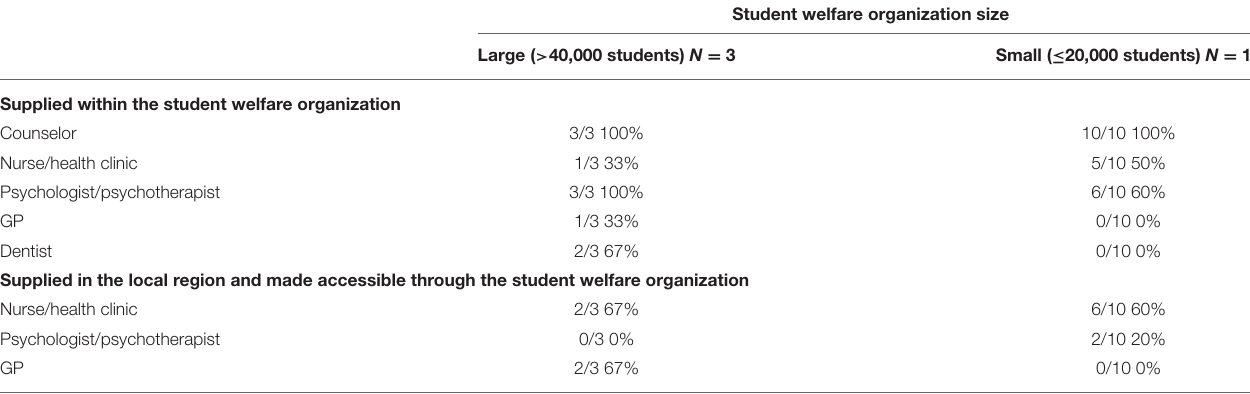
TABLE 4 | Supply of health care services in small and large student welfare